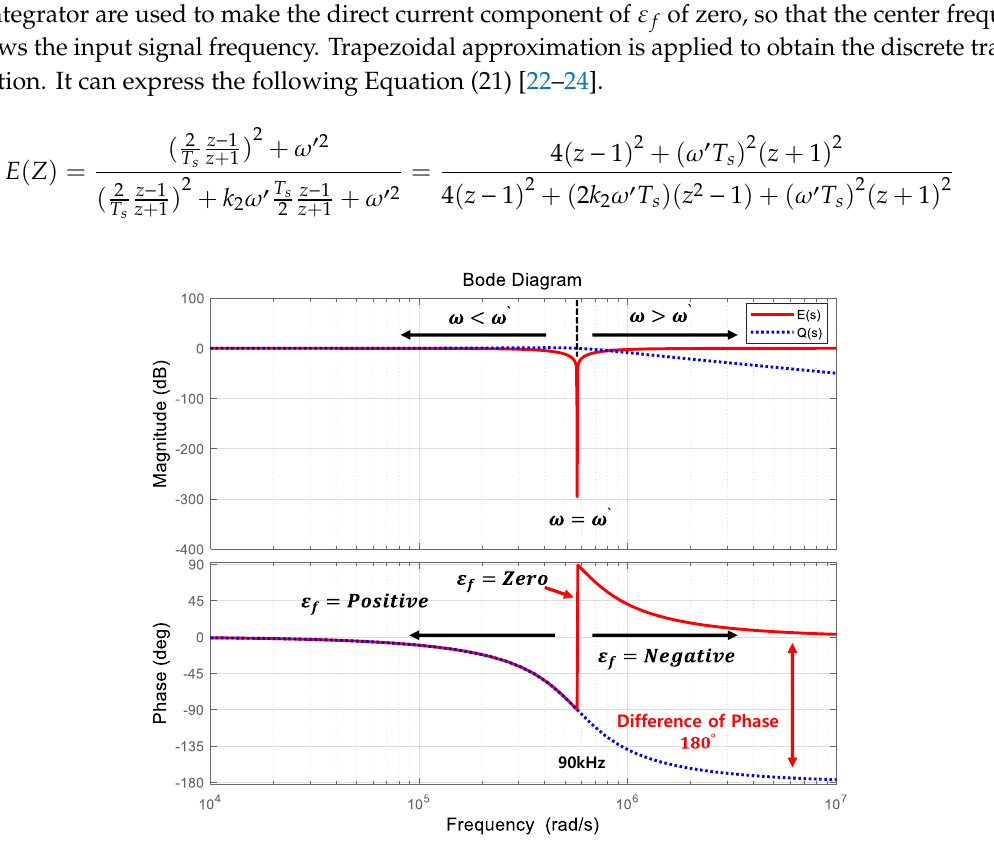
Figure 11. Bode plot of SOGI–FLL.